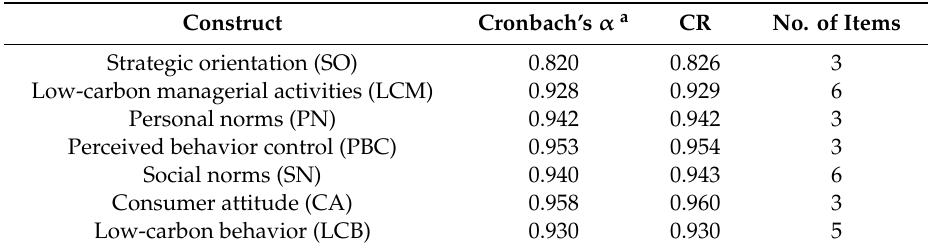
Table 6. Results of the reliability